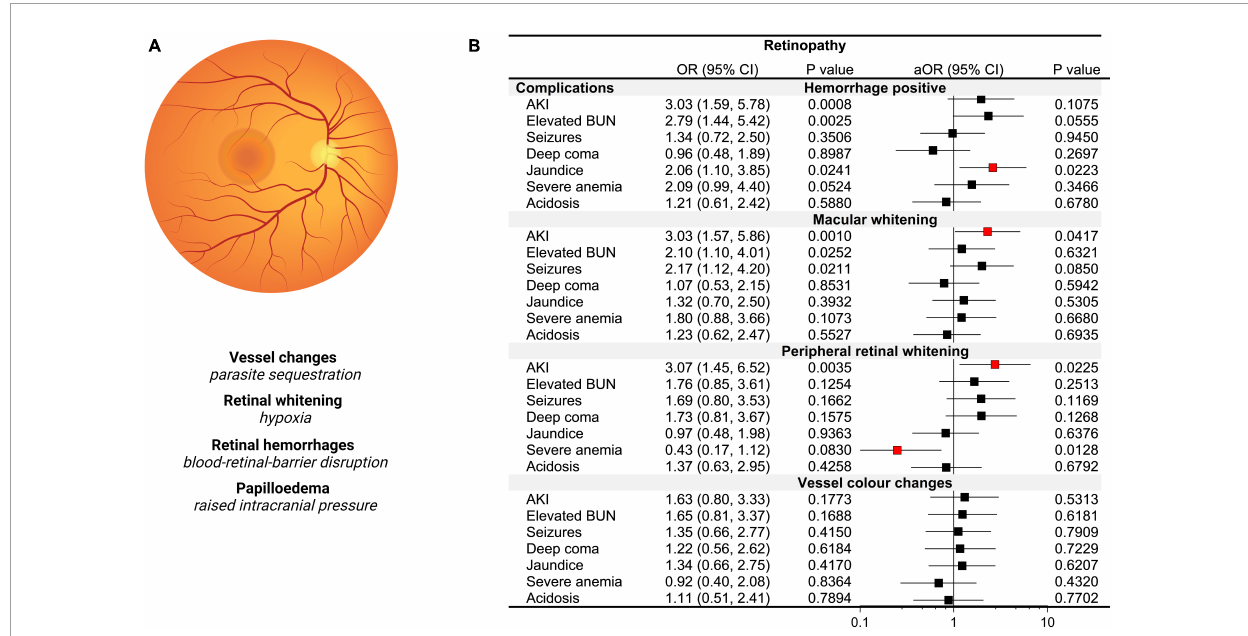
FIGURE5 Acute kidney injury (AKI) and retinopathy based on BBB integrity and changes in plasma osmolality. (A) Diagram of an indirect ophthalmologic view of the retina with an accompanying description of malaria-specific retinal changes and pathological correlates. (B) Forest plot depicting the odds ratios (OR) and adjusted OR (aOR) from logistic regression models with the retinopathy category as the dependent variable and severe malaria complications as the independent variable. Adjusted models included age, sex, the presence of BBB disruption and osmolality